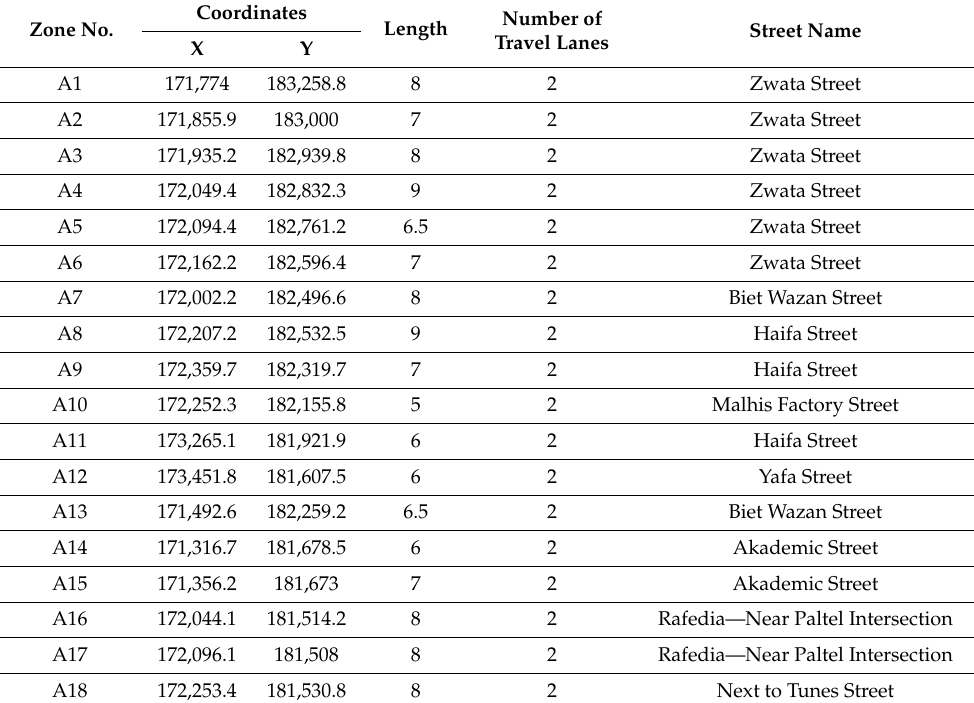
Table 1. Locations, coordinates, and lengths of speed humps for Zone A. Zone